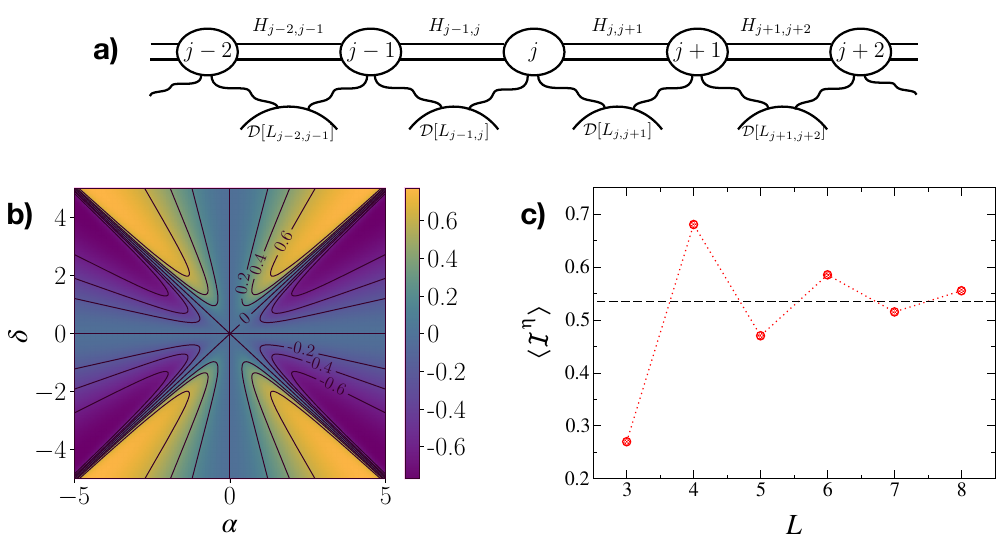
Figure 2. ( a ) Setup to create persistent currents. The cavities interact unitarily via local Hamiltonian terms H j , j + 1 and dissipatively via engineered reservoirs induced by the dissipators η ( b , c ) Circulating current for a minimal scheme of non-local dissipation, as a function of: ( b ) the j I parameters α , δ (cluster mean-field data); ( c ) the system size L (exact diagonalization up to L = 8. Consistent results have been obtained with matrix product operators, enabling to reach much longer sizes